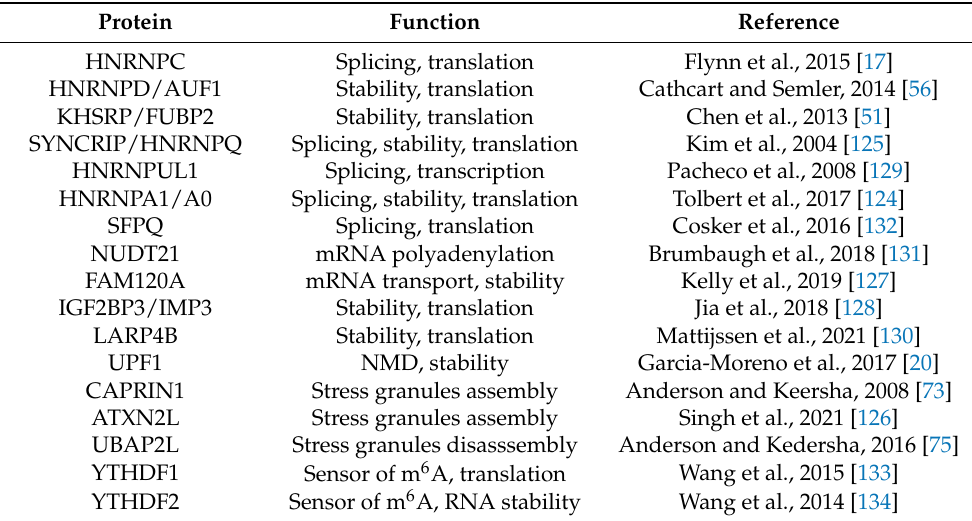
Wang et al., 2014